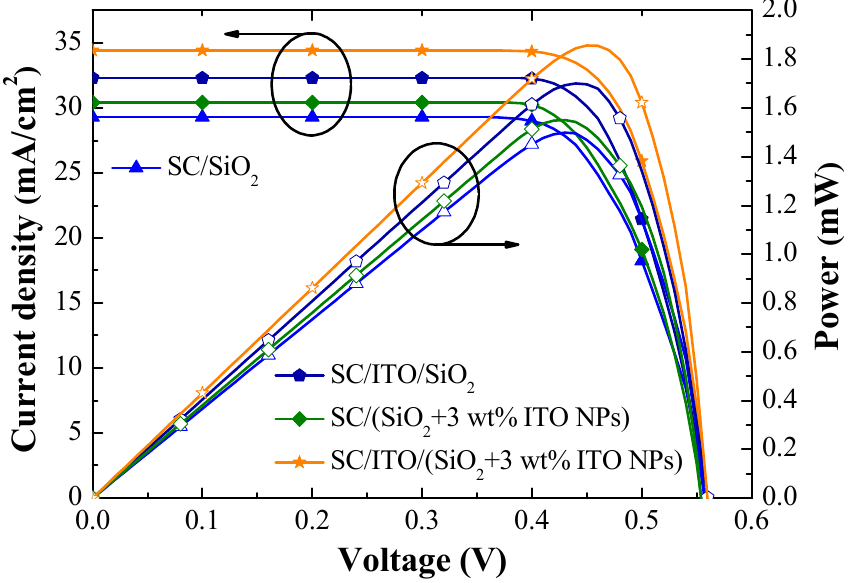
Figure 12. Photovoltaic J-V curves of a cell with an ARC of SiO 2 , a cell with an ARC comprising an ITO layer beneath a SiO 2 layer, a cell with an ARC of SiO 2 and 3 wt% ITO-NPs, and a cell with an ARC comprising an ITO layer beneath a layer of SiO 2 and 3 wt% ITO-NPs.